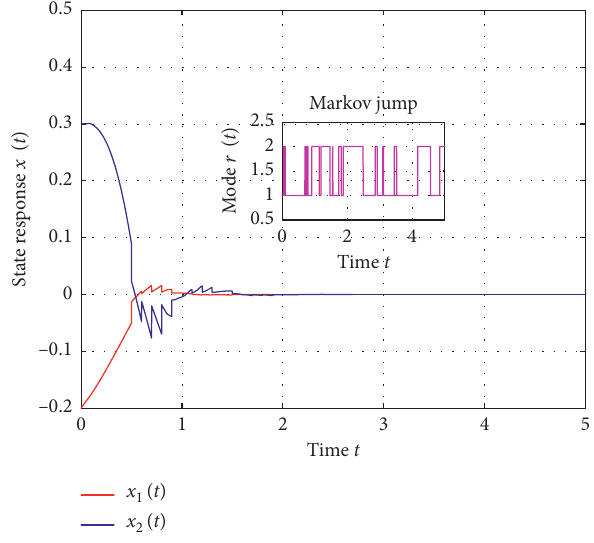
Figure 2: Curve of x ( t ) for Example 1 under